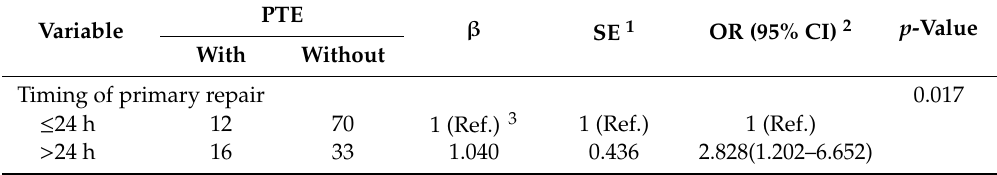
Table 2. Logistic regression analysis of post-traumatic